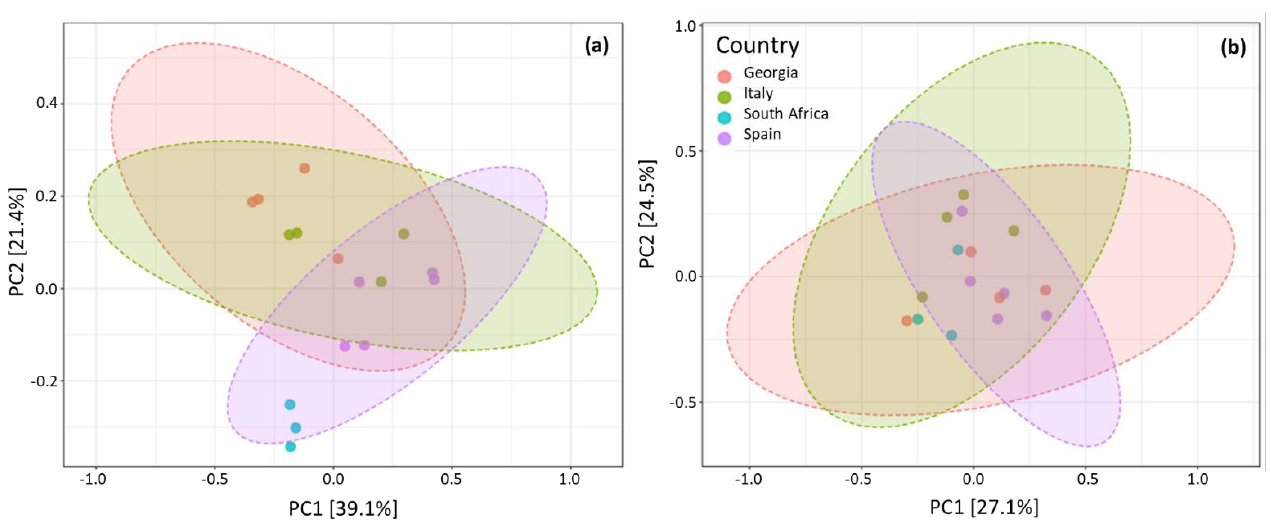
Figure 4. Two-dimensional PCoA for Local ( a ): (PERMANOVA) F − value: 1.925; R − squared: 0.3249; p − value: 0.013) and Cabernet Sauvignon ( b ): (PERMANOVA) F − value: 3.657; R − squared: 0.4776; p − value: 0.001) of the Georgian (red), Italian (green), Spanish (light blue), and South African (blue) samples.